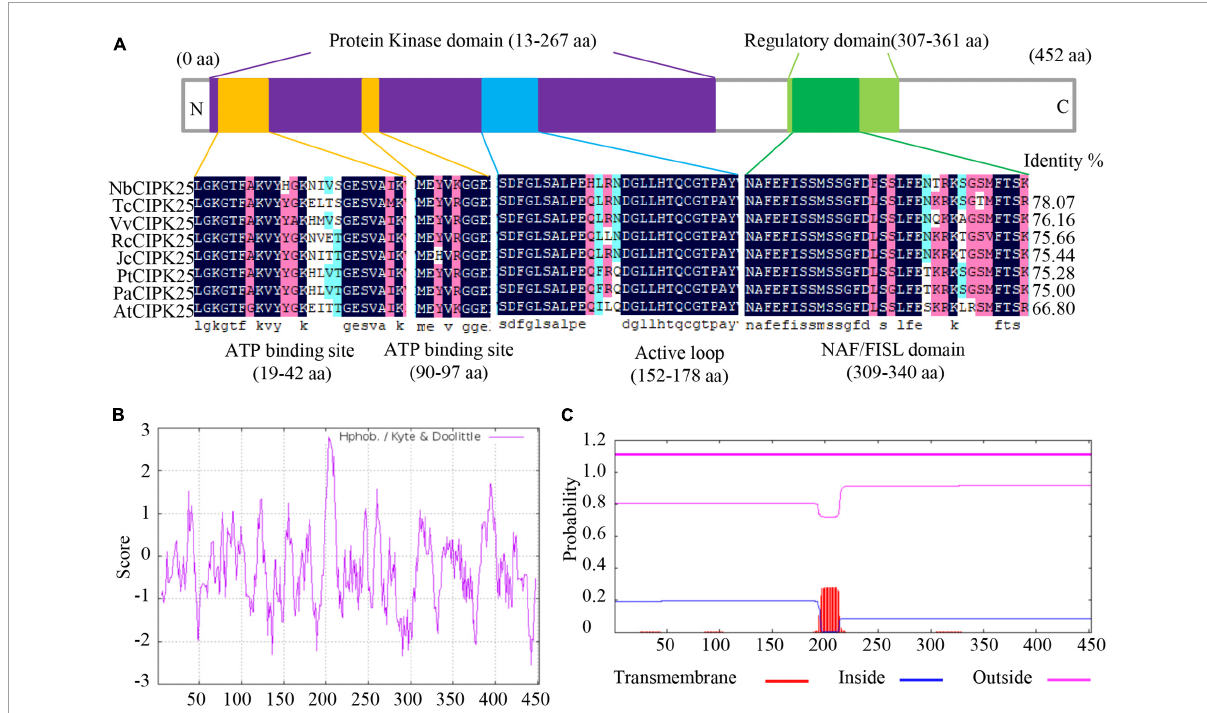
FIGURE1 NbCIPK25 identification by sequence analysis. (A) The conserved domain of NbCIPK25 compared with homologous genes from other species, including Theobroma cacao CIPK25 (TcCIPK25), Vitis vinifera CIPK25 (VvCIPK25), Ricinus communis CIPK25 (RcCIPK25), Jatropha curcas CIPK25 (JcCIPK25), Populus trichocarpa CIPK25 (PtCIPK25), Populus alba CIPK25 (PaCIPK25), and Arabidopsis thaliana CIPK25 (AtCIPK25). (B) Hydrophobicity plot of NbCIPK25. (C) The predicted transmembrane domain of